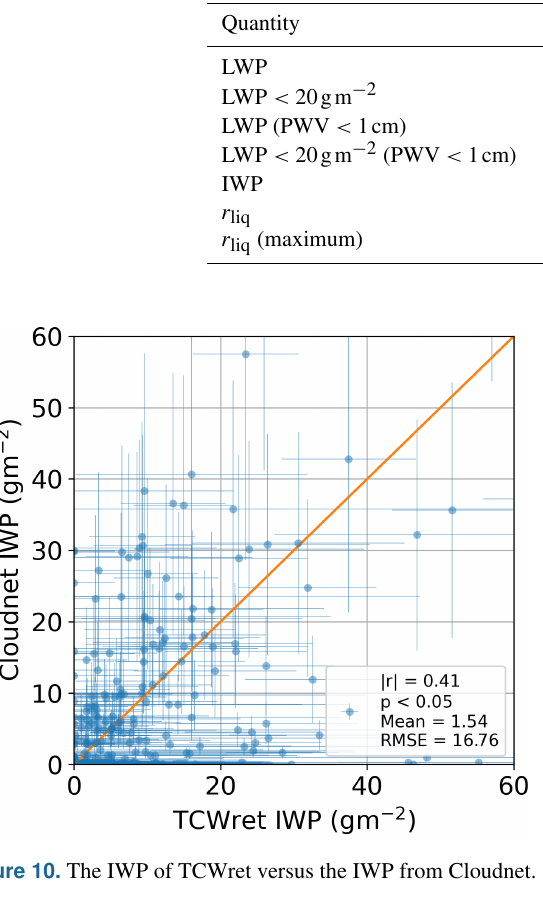
Figure 10. The IWP of TCWret versus the IWP from